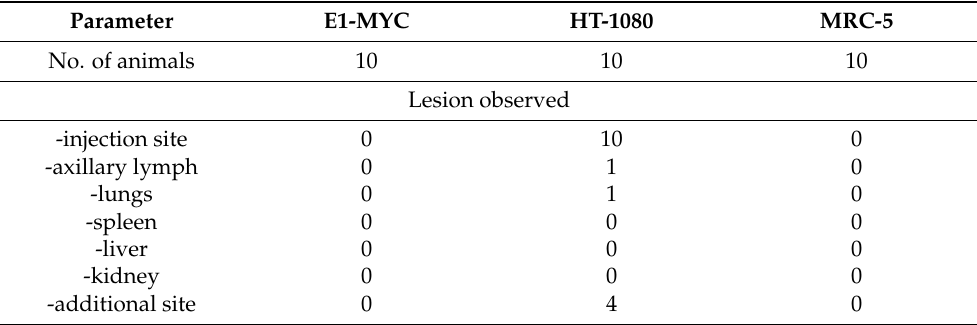
Table 1. In vivo tumorigenic assay. Pathological observations after implantation of E1-MYC, HT-1080, and MRC-5 in athymic nude